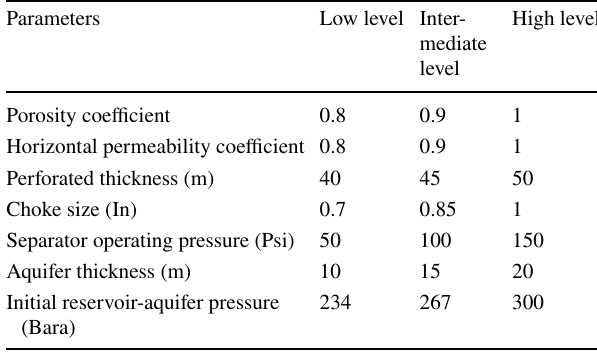
Table 11 Validation of the sensitivity analysis performed on the NPV target function using statistical variables